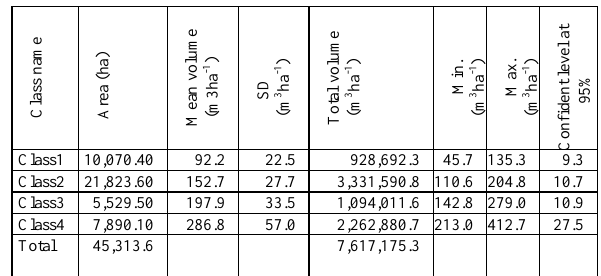
Table 5. Characteristics of stand volume of forest strata